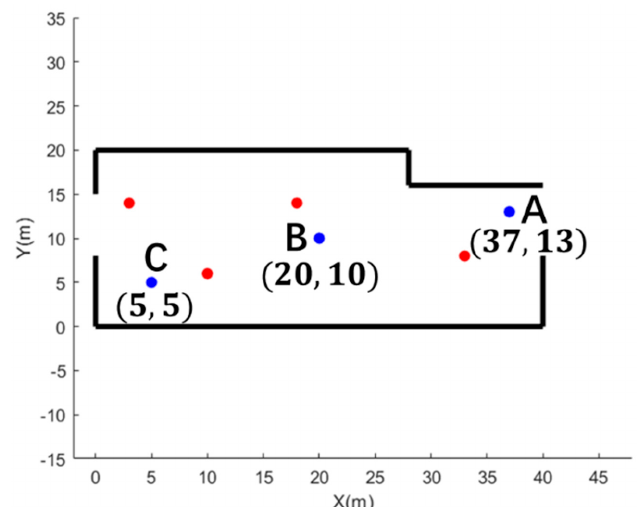
Figure 9. Selected Test Points: the blue dots are selected three test points; the red dots are the location of ANTs.